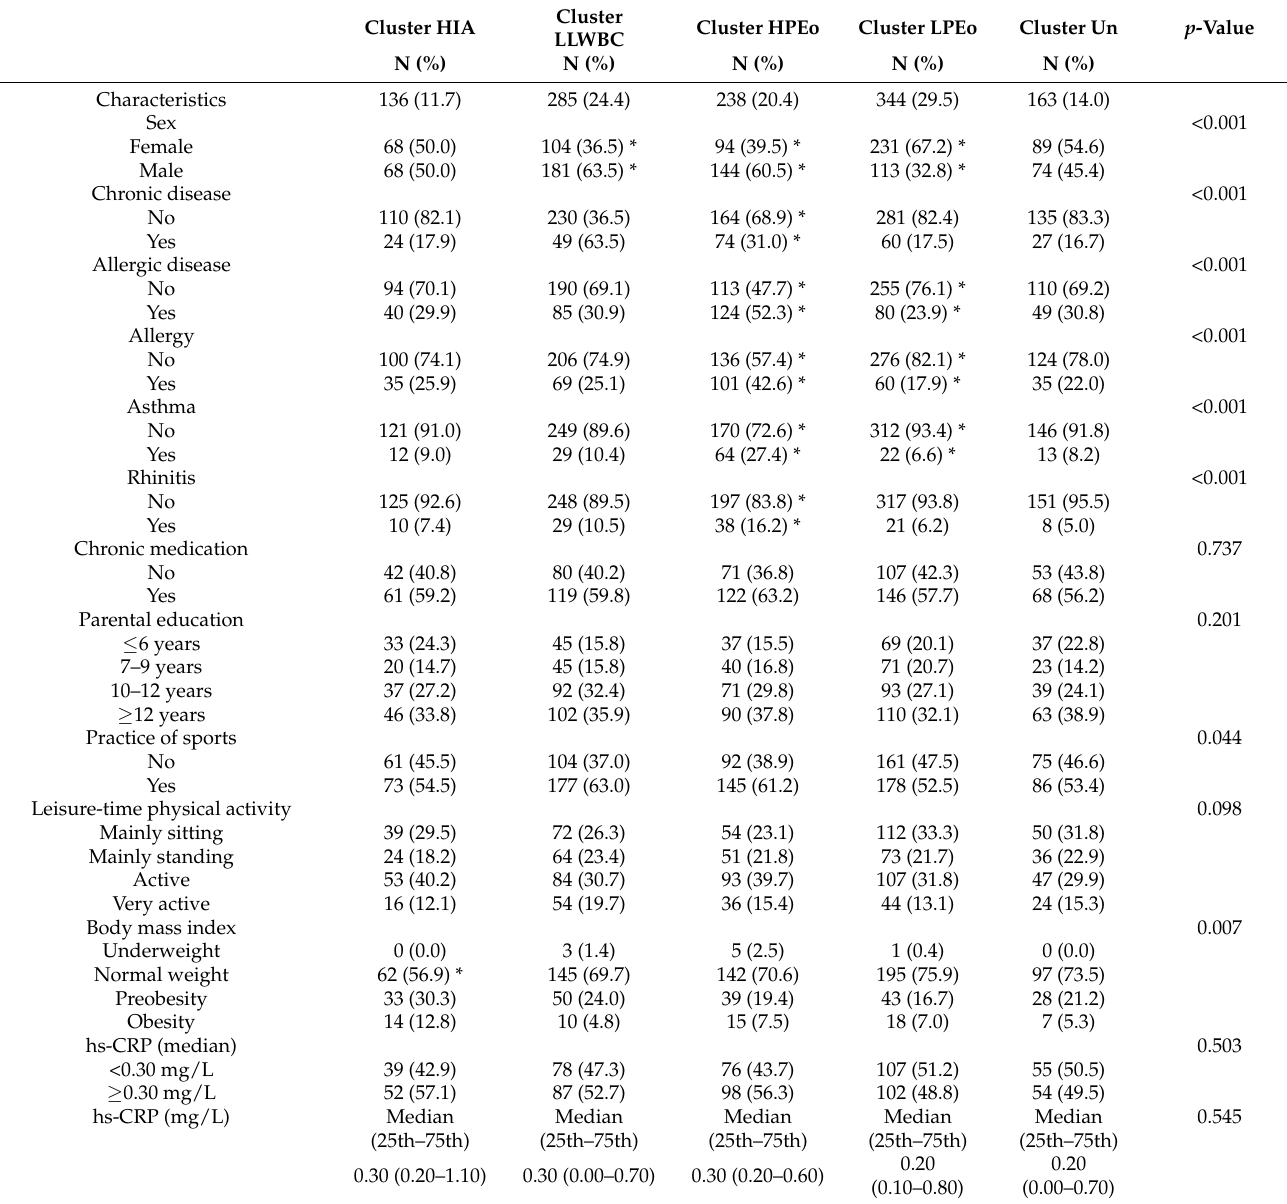
Clusters according to sociodemographic and health characteristics are drawn in Table 2. Cluster HIA showed a significantly higher percentage of individuals with pre- obesity and obesity. Cluster LLWBC had a significantly higher percentage of individuals practicing sports and higher percentage of participants reporting being very active in leisure-time physical activity. Cluster HPEo showed a significantly higher percentage of individuals with chronic disease, allergy, asthma and rhinitis. Cluster LPEo had the highest percentage of females and fewer individuals who reported allergic disease. Cluster Un had a higher percentage of participants with highest parental education, though without statistical significance. Table 2. Comparison of demographic and behavioral characteristics by